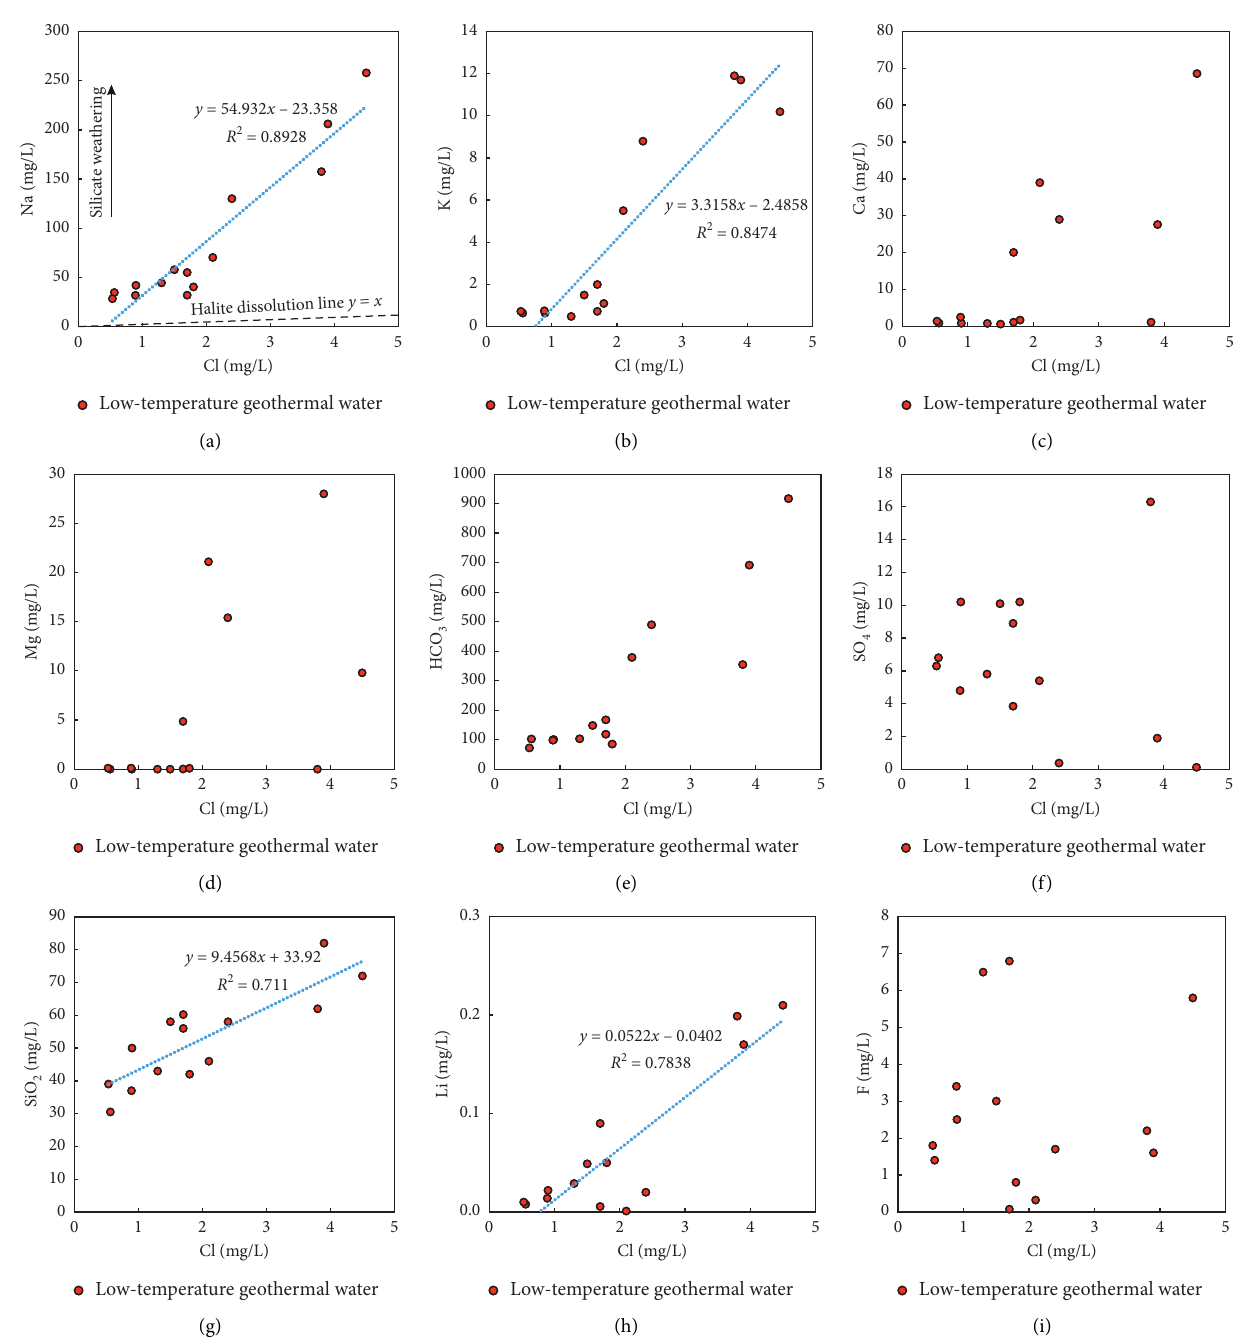
Figure 4: The plots of Cl against (a) Na, (b) K, (c) Ca, (d) Mg, (e) HCO